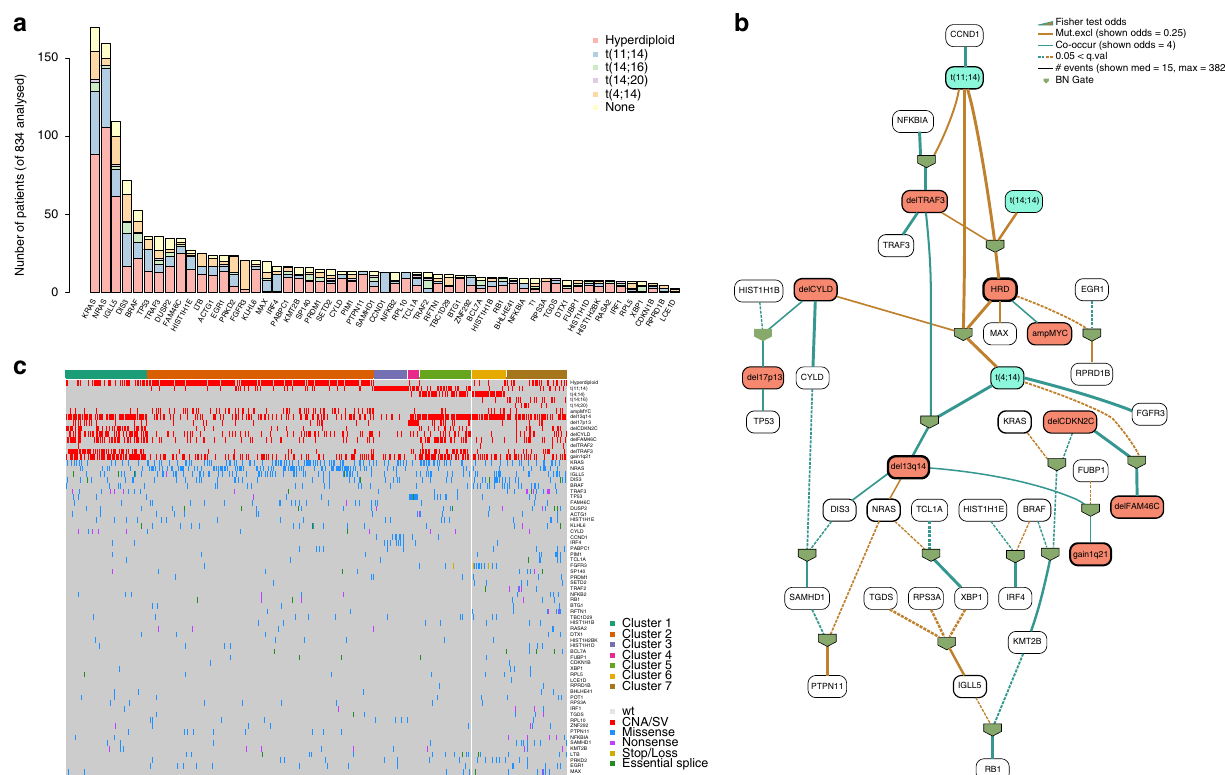
Fig. 1 The landscape of exome-based driver events MM. a Landscape of driver mutations in MM. Each bar represents a distinct positively selected gene and each bar ’ s color indicates its prevalence across the main MM cytogenetic subgroups. b We built the optimal Bayesian network by considering the recurrent SVs and CNAs ( n = 14) and driver SNVs ( n = 55) across 724 MM patients, where the fi nal list of 69 variables was assessed. To further investigate the type of recurrence patterns we fi tted logic gates between parent and child nodes in the network. The gate combination with the most signi fi cant Fisher exact test p value was selected. The line width is proportional to the log hazard ratio of the test. Dashed lines represent non-signi fi cant associations ( p > 0.05). CNAs and translocations were colored in brown and light blue respectively. The thickness of the outline of each box is proportional to the prevalence of the event across the entire series. c The heatmap showing the main MM genomic subgroups across 724 MM patients. The genomic pro fi le of each cluster was generated by integrating the hierarchical Dirichlet process and Bayesian network data. Rows in the graph represent individual genomic lesions, and the columns represent